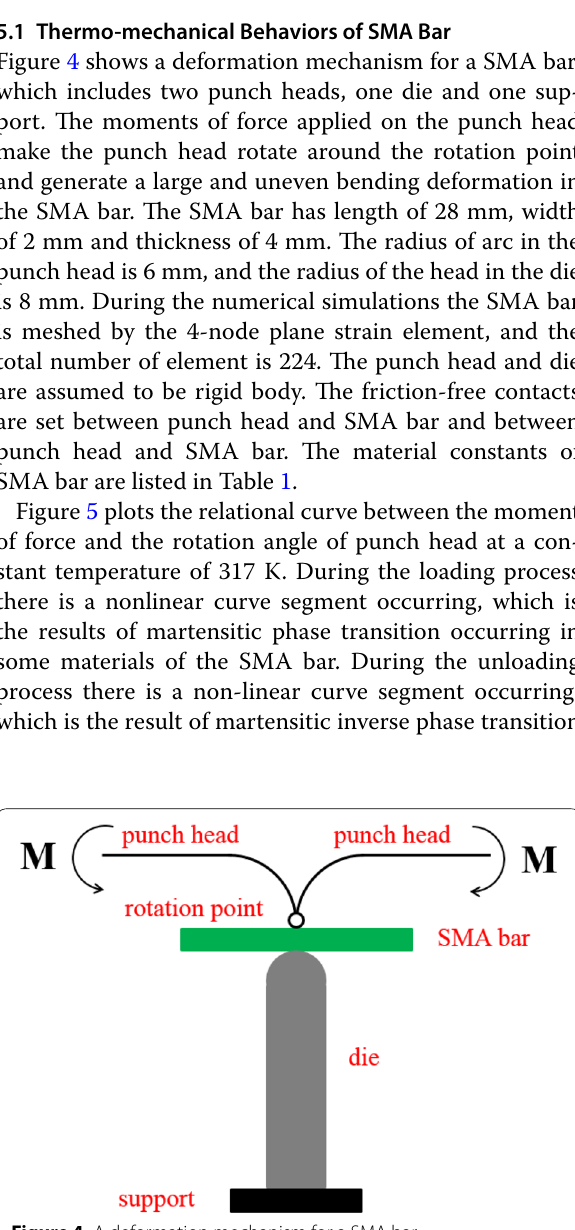
Figure 4 A deformation mechanism for a SMA bar